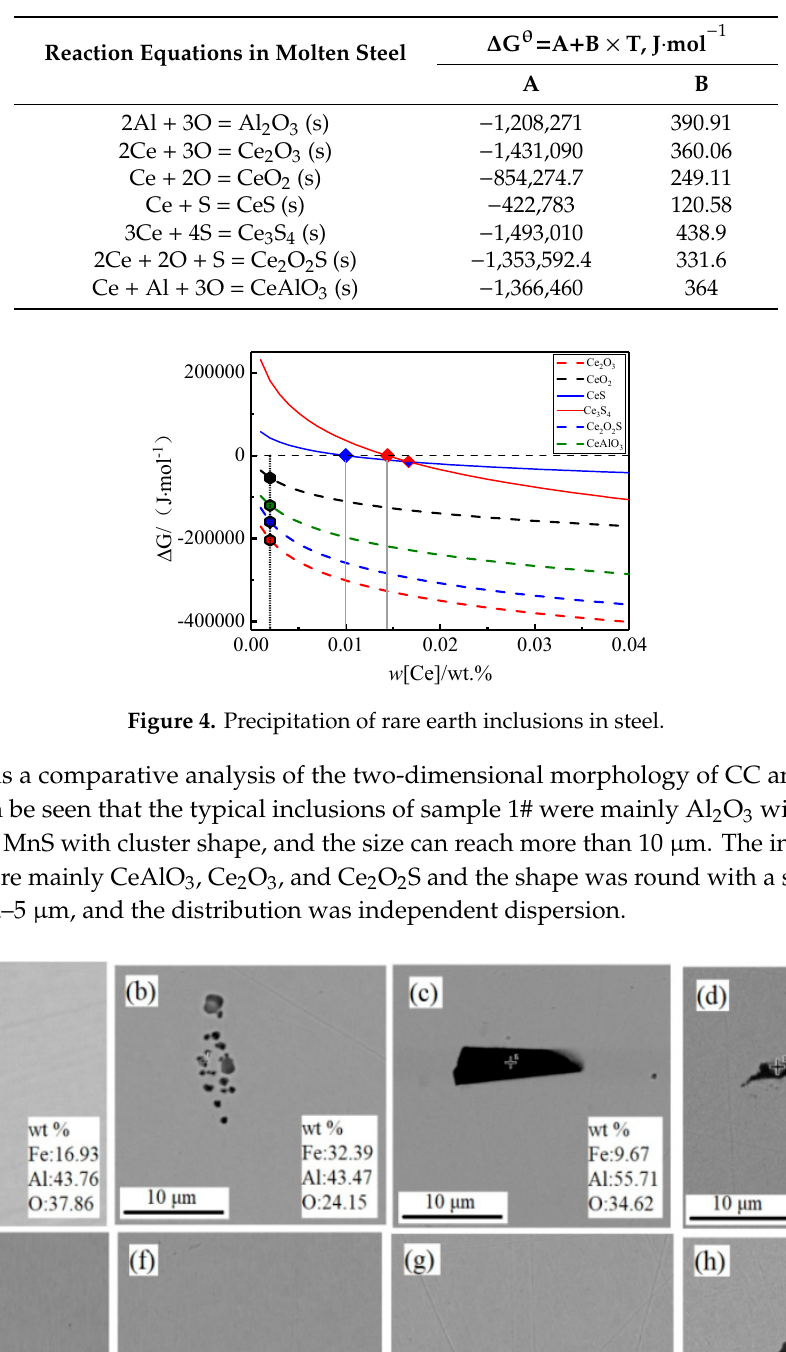
Table 2. Thermodynamic calculation of the rare earth inclusions formation.